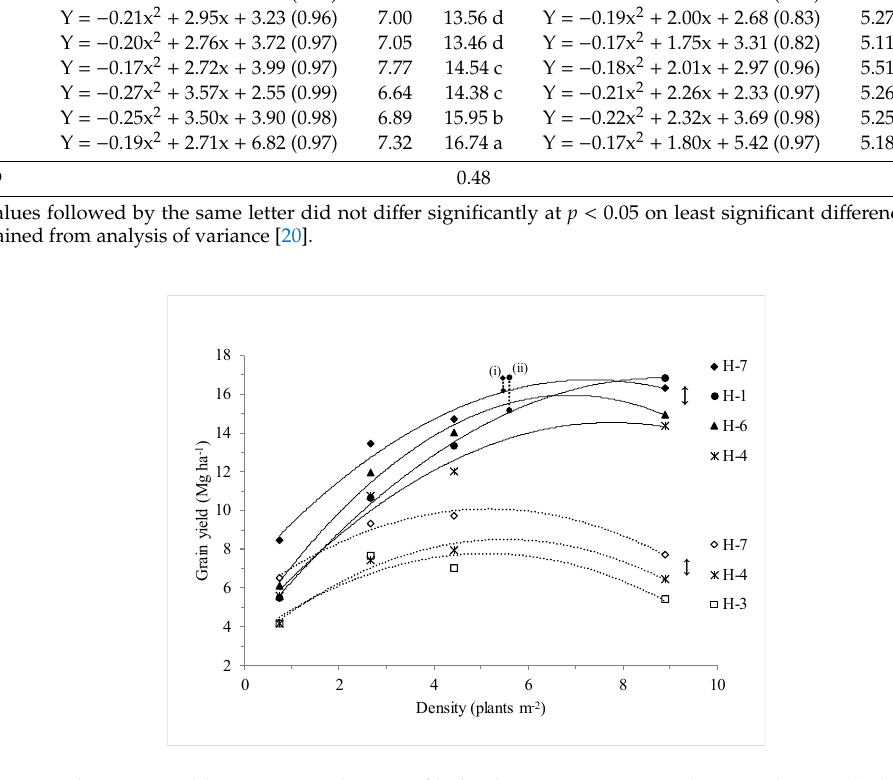
Figure 2. The grain yield response to density of hybrids H-7, H-1, H-6, and H-4 in the NIR (solid lines), and of H-7, H-4, and H-3 in the LIR (dotted lines), following the quadratic function of Table 1. The double arrow in each regime reflects the respective LSD ( p ≤ 0.05). The vertical bars represent the potential yield loss of (i) H-7 and (ii) H-1 in NIR (simulating a season with su ffi cient rainfall) at the optimum density of LIR (supposed to be chosen for the case of few rainfalls) computed by the quadratic equations of Table